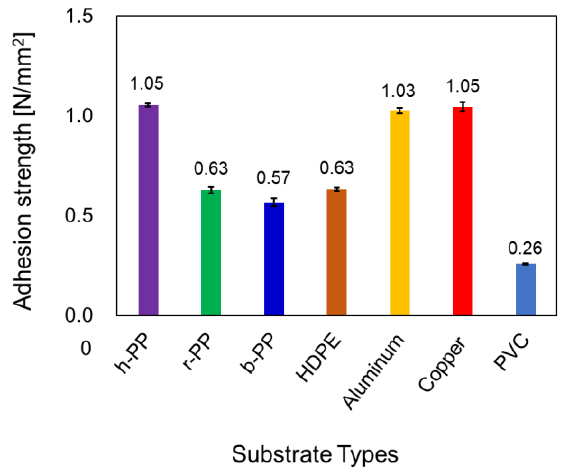
Figure 5. Adhesion strength of the modified h-PP attached with other substrates (h-PP, r-PP, b-PP, and HDPE), which were also modified with BHA-TBAEMA under the optimized conditions, and non-modified aluminum, copper, and PVC film. These results were evaluated by the tensile shear tests.